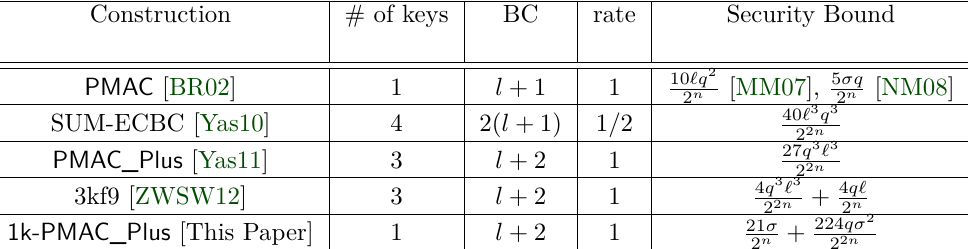
Table 1: BC denotes block cipher calls. Rate defines the average number of message blocks processed by a single execution of block cipher. l denotes the number of message blocks in a mesage, q denotes the total number of queries, ‘ denotes the maximum number of message blocks in all q queries and σ denotes the total number of message blocks in all q